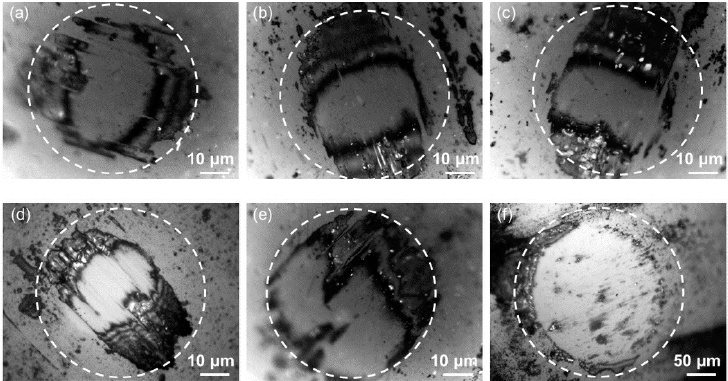
Figure 5. Raman spectra measured on the worn surfaces of the H ‐ DLC films at different sliding velocities.